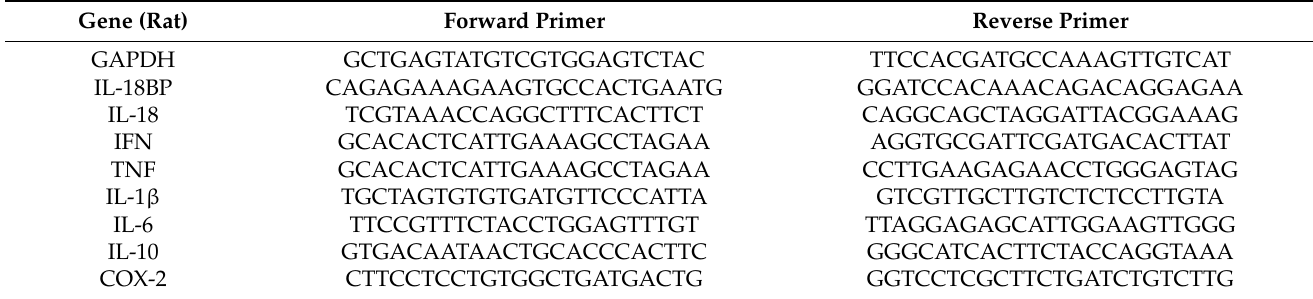
Table 1. Sequence of primers involved in this study.